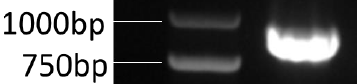
Figure 3. PCR results of the target genes